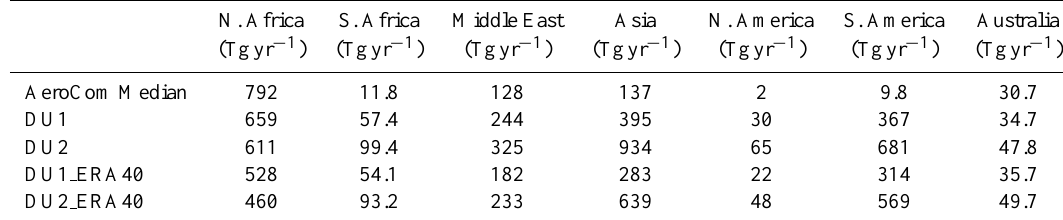
Table 6. Regional dust emissions (Tgyr − 1 ) (regions shown in Fig. 3c) for the different